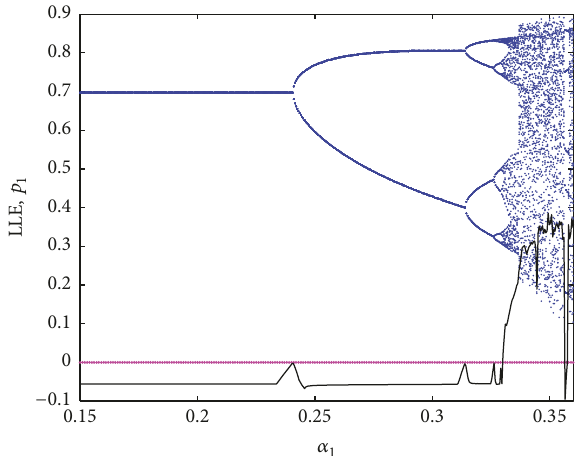
Figure 5: The bifurcation diagram of price and LLE with respect to 𝛼 𝜃 = 0.6 , 𝛼 = 0.5 , 𝑤 = 1 , and 𝛼 = 0.01 . 1 when 𝑖 2